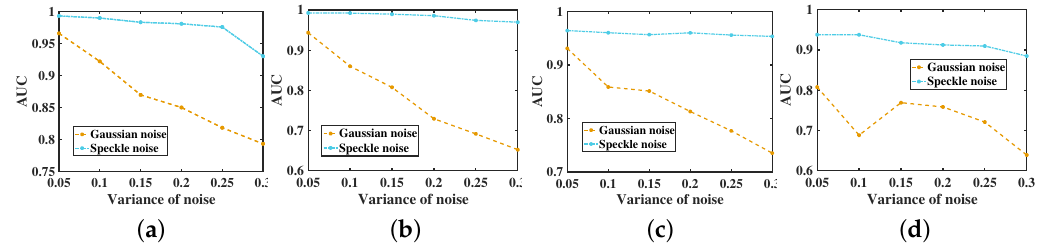
Figure 25. The plot of the AUC values with respect to different levels of Gaussian and Speckle noises on the four data sets. ( a ) Mexico data set. ( b ) Ottawa data set. ( c ) Yellow River data set. ( d ) Campbell River data